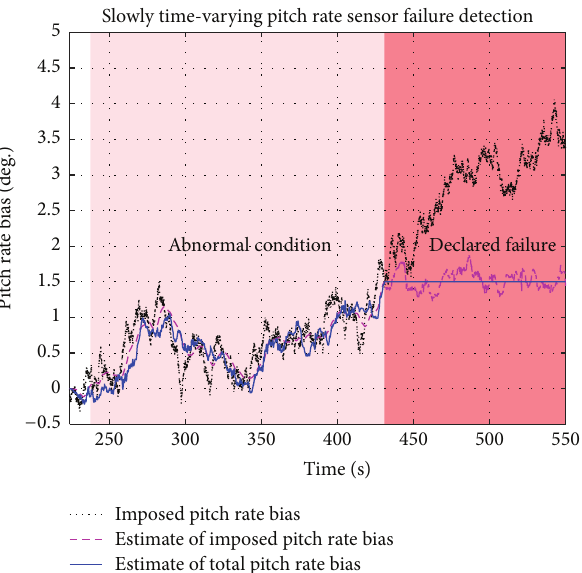
Figure 8: Detection and accommodation of slowly building up “soft”